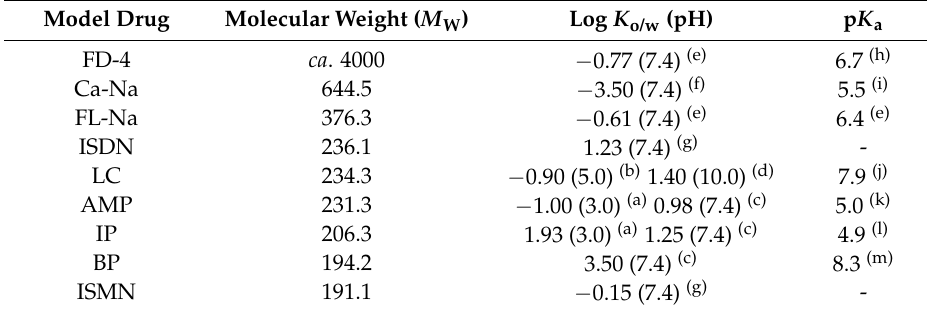
Table 1. Physicochemical properties of drugs